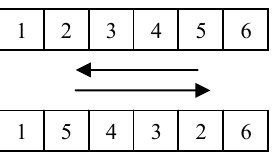
Fig. 2. The illustration of the